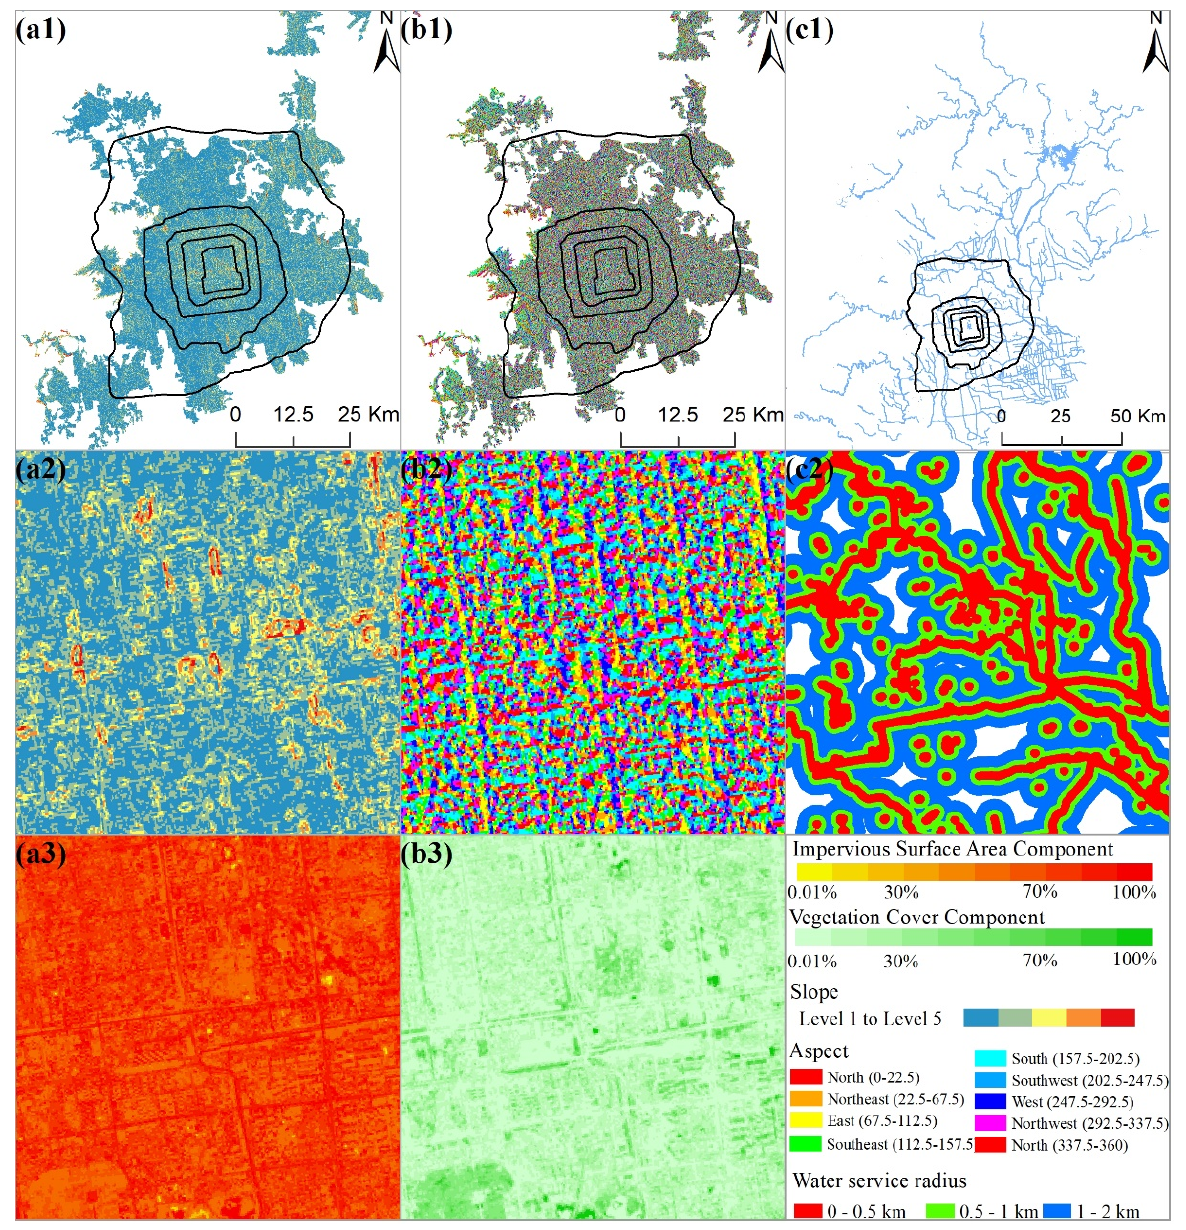
Figure 7. Spatial diagram of urban land components and physical medium environments. ( a1 , b1 , c1 ) represent the spatial distribution of slope, aspect, and water resources. ( a2 , a3 , b2 , b3 ) represent a same sample region of the slope, aspect, impervious surface area component, and vegetation cover component; and ( c2 ) represent a sample region of water resources service radius, respectively.